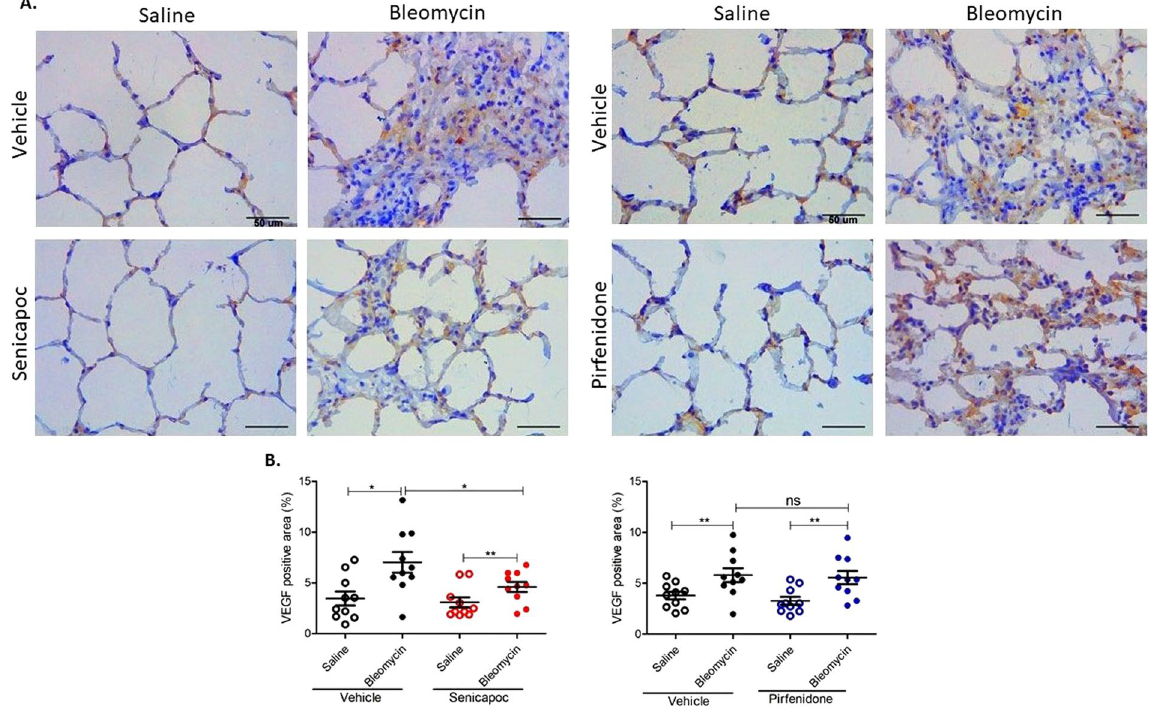
Figure 4. Senicapoc, but not pirfenidone, down regulates VEGF expression that was increased by bleomycin. ( A ) The panels show representative anti-VEGFA immuno-stained sections of lung segments from sheep that were treated with either vehicle, senicapoc or pirfenidone. The lung segments from individual sheep were infused with either saline (left-side images), or bleomycin (right-side images). ( B ) Shows the data for the percentage VEGF-positive area per total field area of lung parenchyma for the different treatment groups. Data show individual values plus mean, (n = 10 sheep). Significance was determined using a paired t test between lobes from the same treatment group and an unpaired t test between lobes from different groups, * p < 0.05, ** p < 0.01, ns-not significant. Data represent mean ( ± SEM). Scale bars = 50 µ